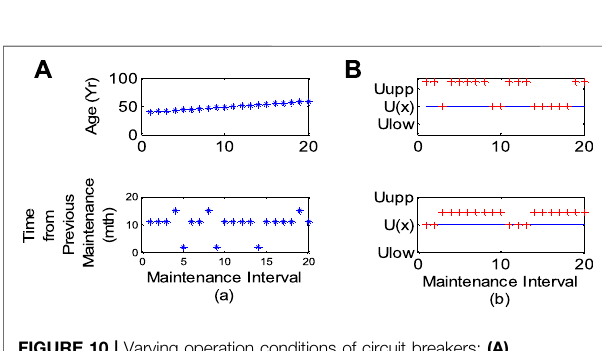
FIGURE 10 | Varying operation conditions of circuit breakers: (A) operation variations; (B) secondary uncertainty of each operation